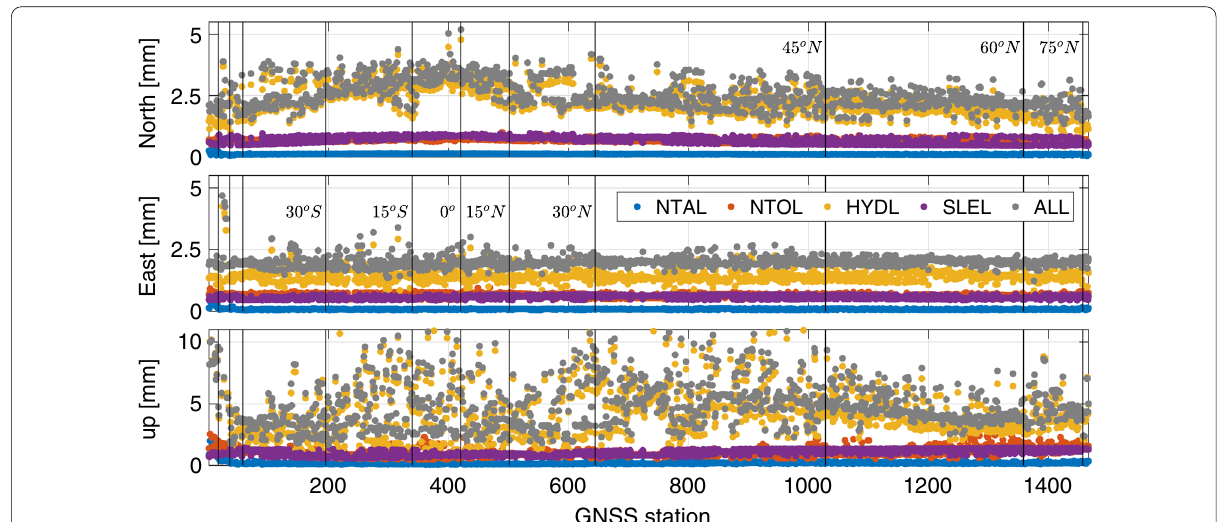
Fig. 3 RMS values of the differences between the site displacements of GCTI20 and ESMGFZ in the CM-frame at GNSS stations, ordered by latitude. Distinct loading components as well as their combination (ALL Please note the different scale for the up direction. The vertical lines indicate the borders between 15 ◦ latitude